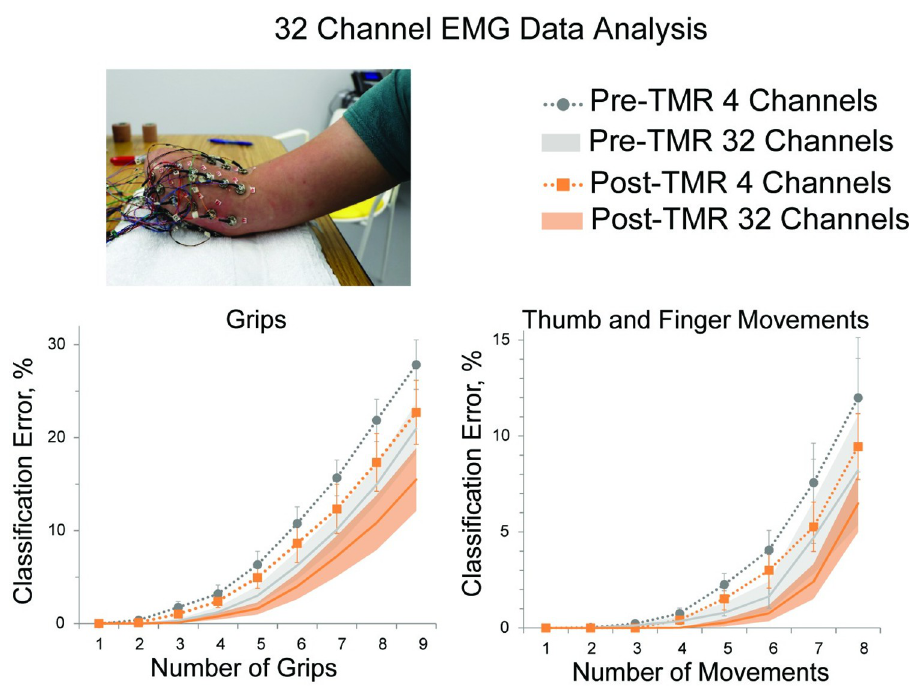
Fig 4. 32-channel EMG data collection setup ( top ) and results ( bottom ) for 6 subjects. Offline classification error rates are plotted for the system with increasing number of grips configured ( left ) and thumb and finger movements ( right ). Colors represent data collected Pre-TMR ( grey ) and Post-TMR ( orange ) optimized for a system using only 4 channels and all 32 channels. Standard deviations for the 4 channels are shown with error bars and for the 32 channel data with shaded bands.